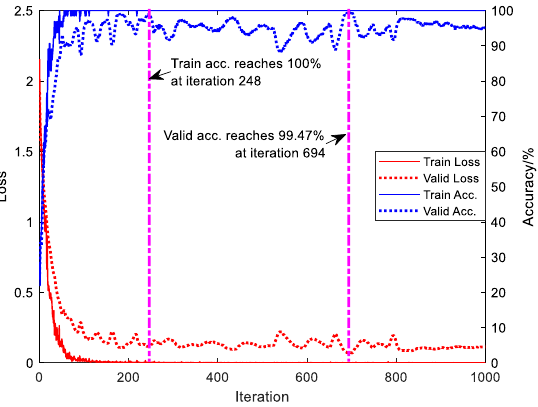
Figure 13. Model training process using the CVG-MFICNN method based on training set I.